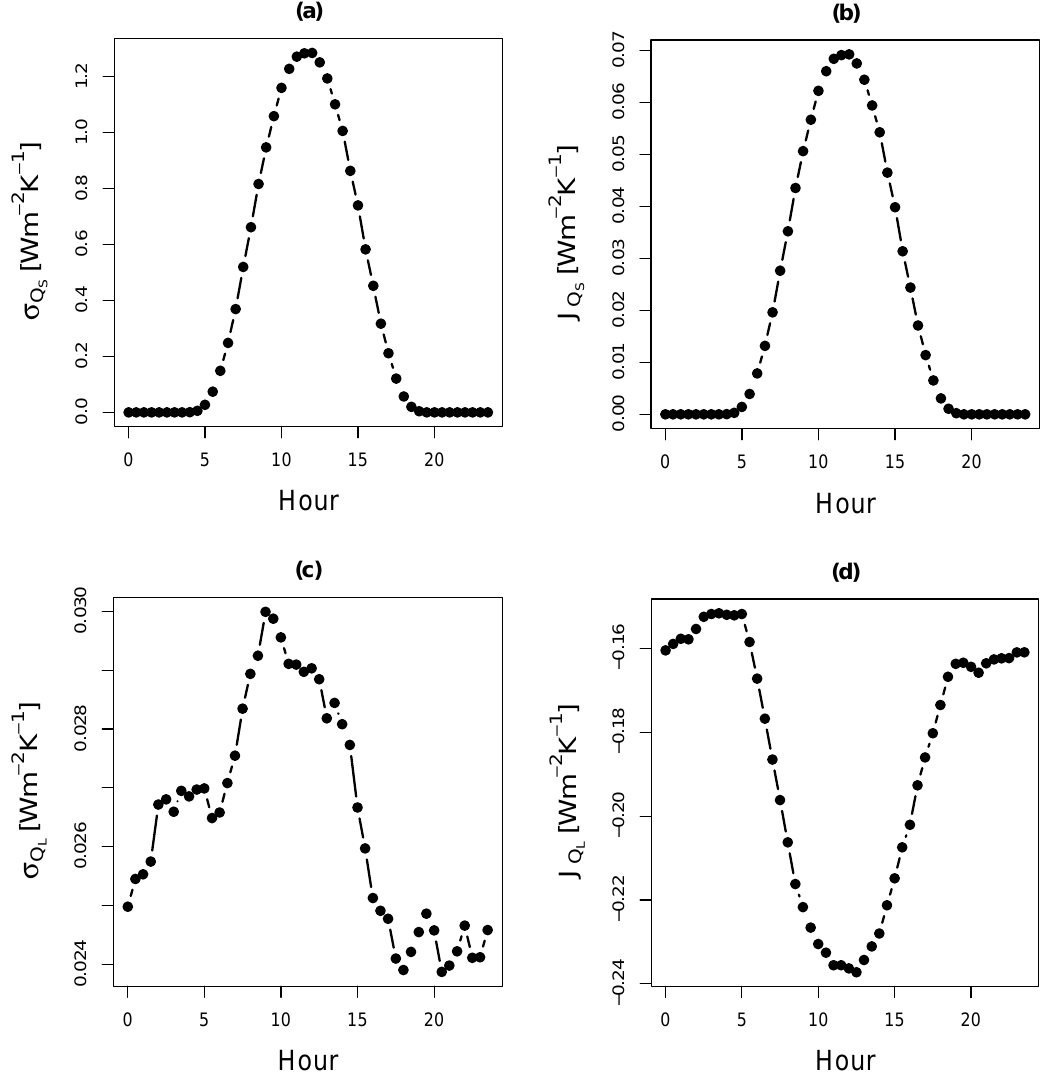
Fig. 3. Mean diurnal entropy terms associated with (a) production due to to conversion of shortwave radiant energy, (b) transport due to shortwave radiation (c) production due to longwave radiant exchange and (d) transport associated with longwave